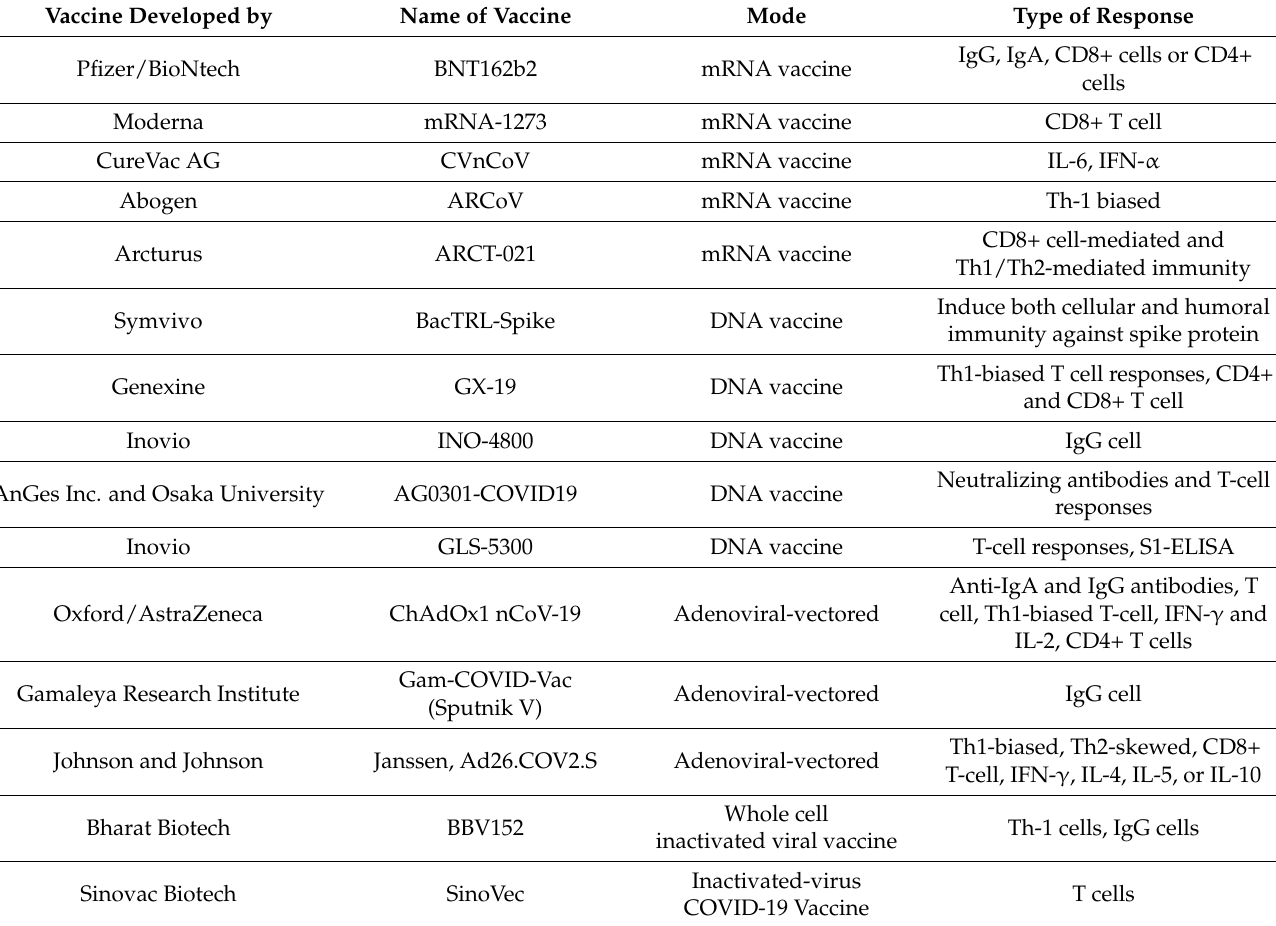
Table 2. List of COVID-19